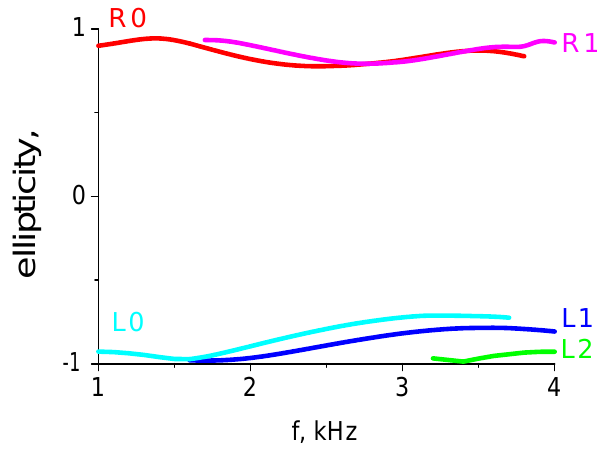
Fig. 6a. Attenuation factor of different modes for the night IRI model of ionosphere.